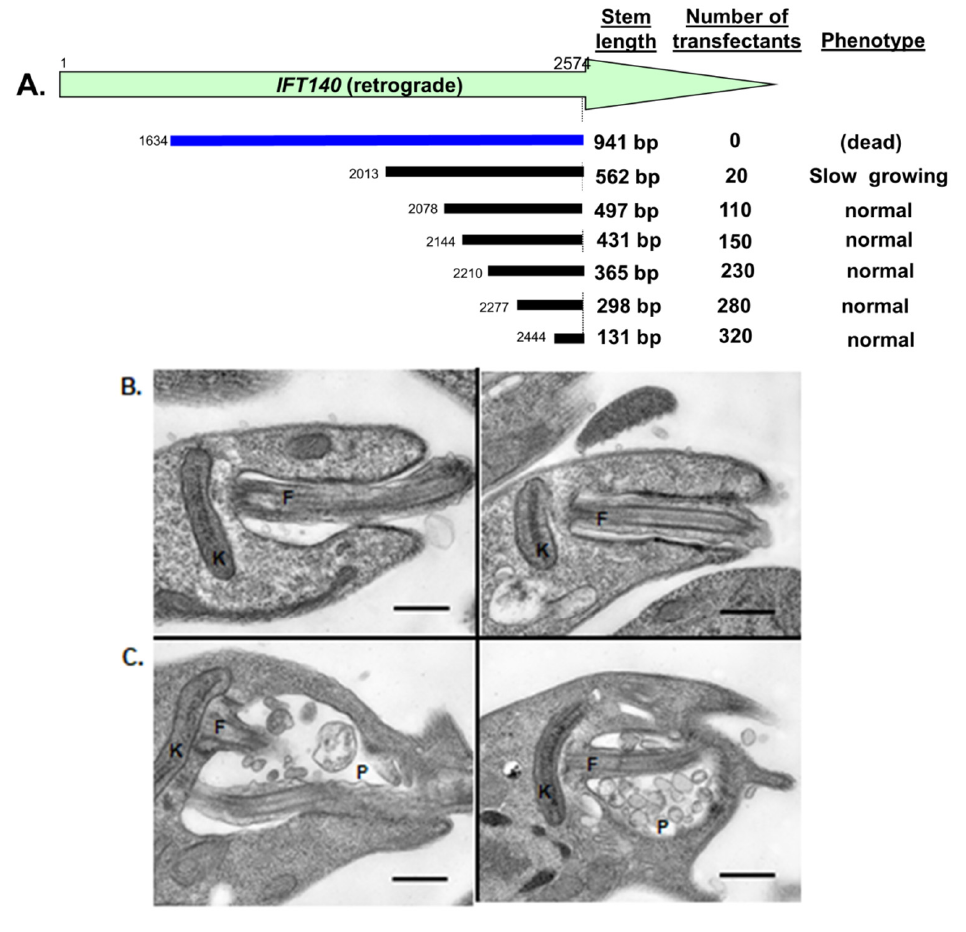
Figure 5. Systematic identification of viable hypomorphic RNAi mutants. ( A ) Map of the IFT140 stems tested, number of colonies obtained after transfection, and the growth properties (when